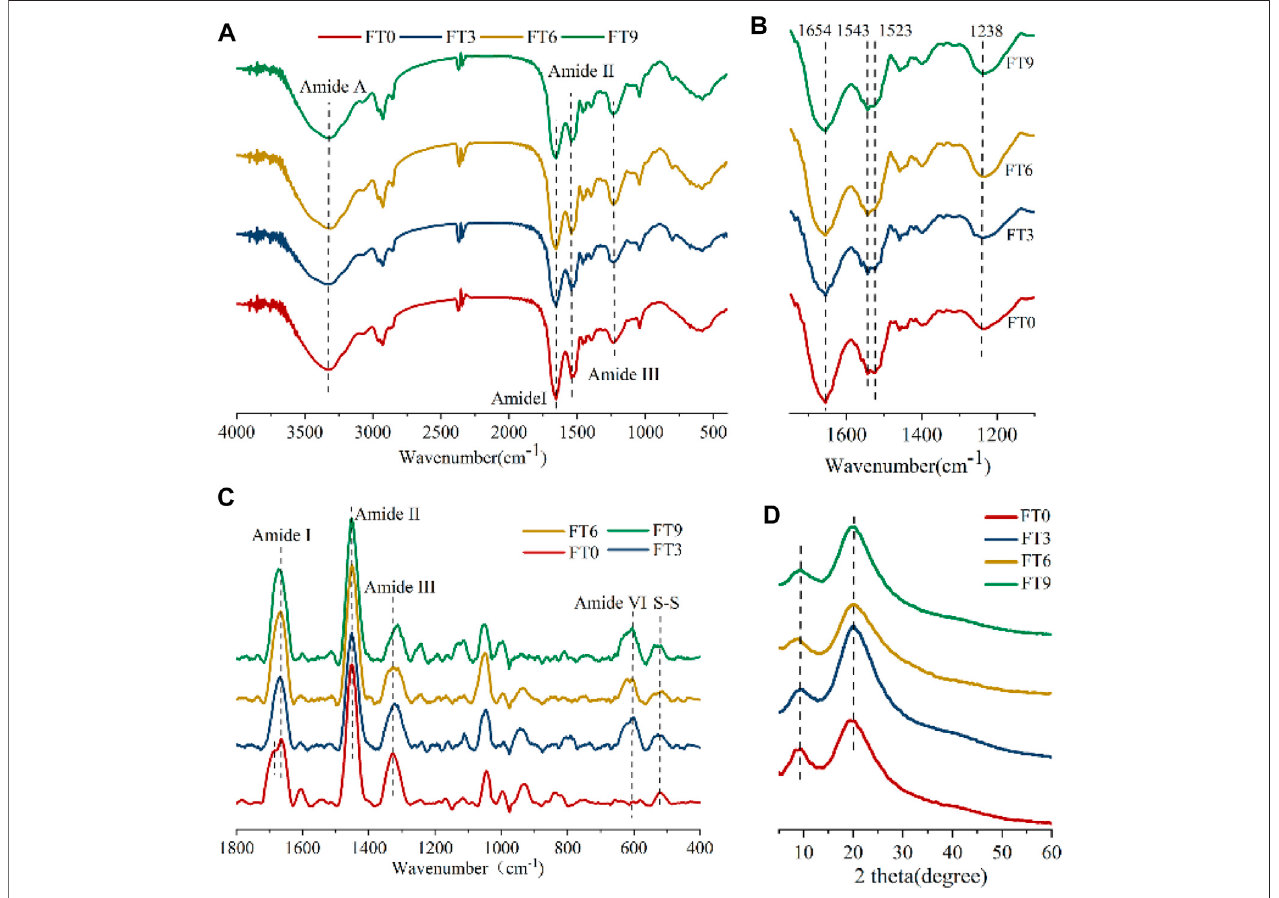
FIGURE 3 | (A – B) The FTIR spectra of RHK samples, (C) Roman spectra, and (D) XRD.